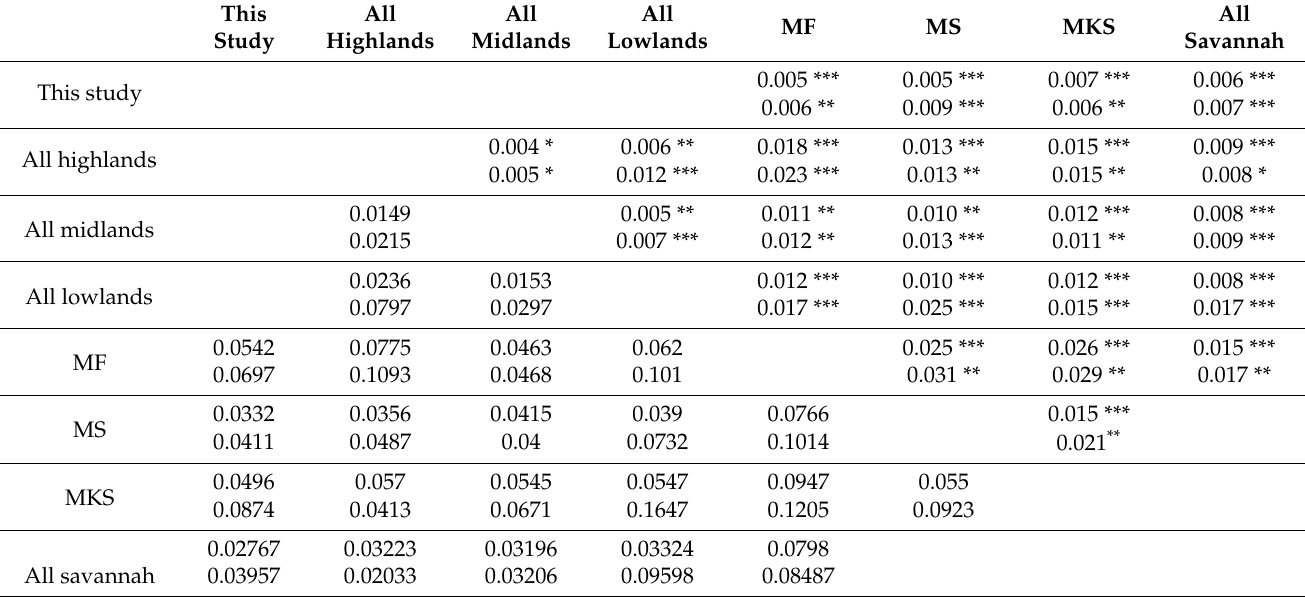
(Figure S4C1, C2). On the basis of AEZ, the A. m. monticola reference was more differenti- ated from the highland (F ST = 0.1093) and lowland (F ST = 0.101) compared to the midland (F ST = 0.0468) AEZs of Ethiopian honey bees in this study, mainly when all sites were considered in the analysis (Table 4; Figure S4B). Table 4. Genetic differentiation based on r7- frag : distance, F ST (lower triangle) and statistical significance, Kst* including permutation test (upper triangle) between honey bees from highland, midland and lowland agro-ecological zones (AEZs) of Ethiopia, pooled on the basis of AEZs as well as mountain forest and savannah areas of Kenyan reference samples from mount Kenya and the Mau region. Analysis was performed by excluding sites with sequence alignment gaps (first rows) and considering gaps as a fifth state (second rows)